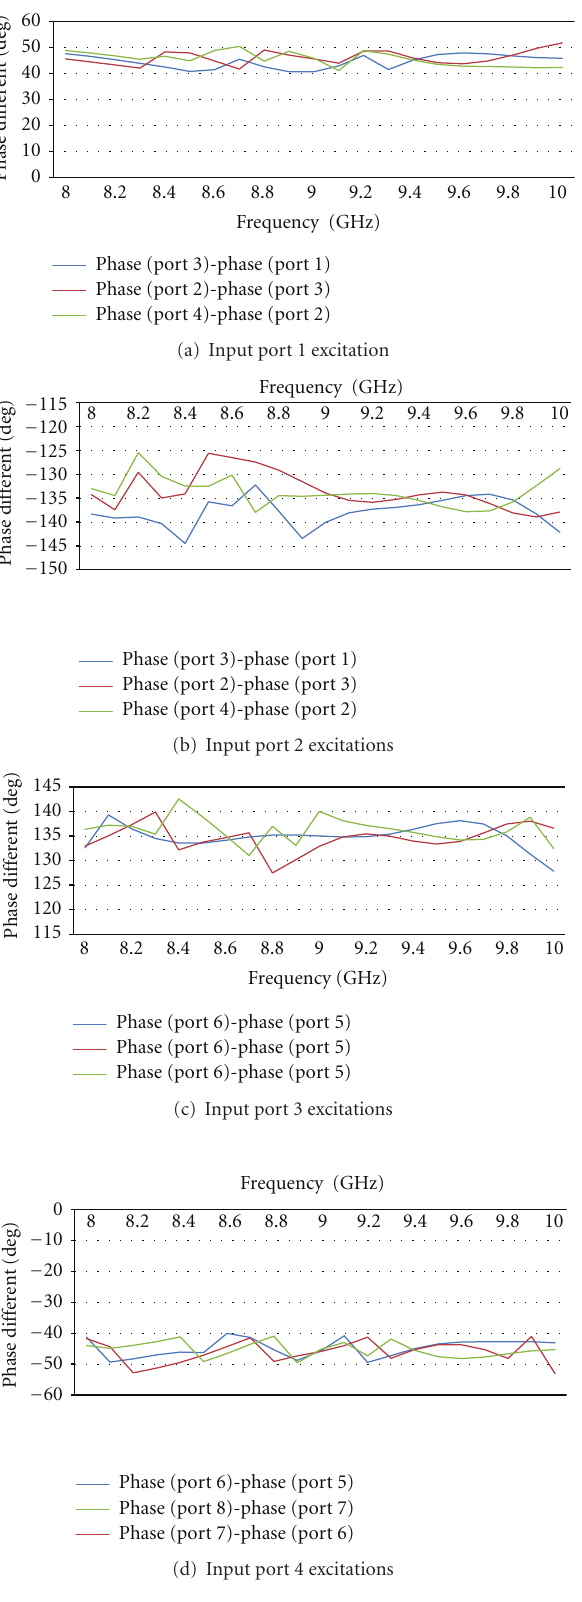
Figure 13: Phase di ff erence of the proposed Butler Matrix when di ff erent ports are fed.